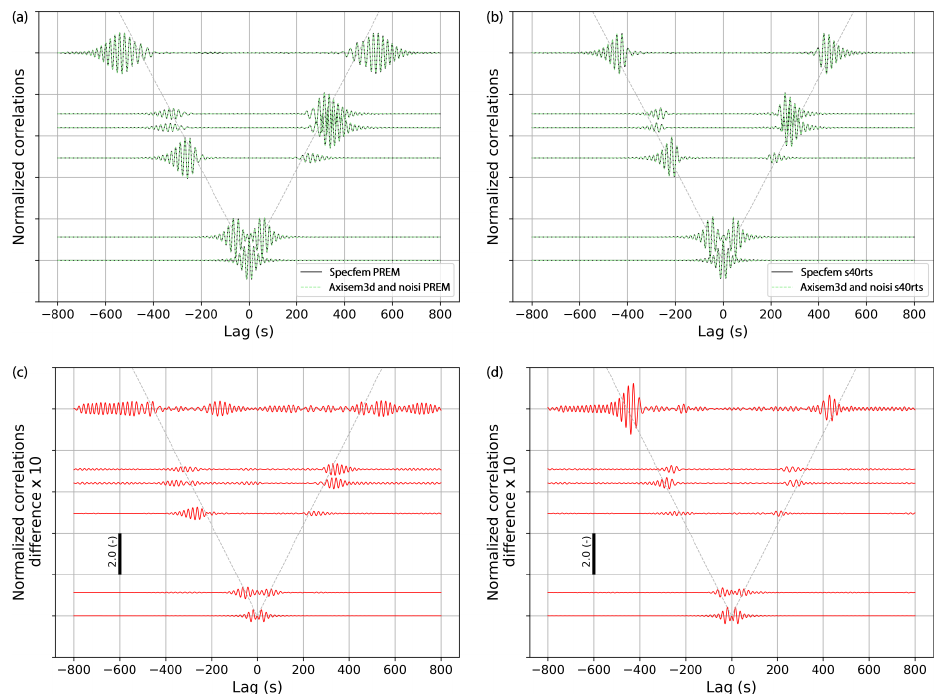
Figure 2. Comparison between two implementations of simulation ambient noise cross-correlations with PREM (a) and S40RTS (b) . Both panels shows correlations modeled with SPECFEM3D_GLOBE, as well as with noisi , in which the latter uses Green’s functions modeled with AxiSEM3D. A moveout of 3kms − 1 is shown by the dashed gray line (note that the y axis is only approximately to scale for better visibility; however, the cross-correlations for both models are arranged at the same distances). The correlations are low-pass filtered by a type II Chebyshev filter with a stopband frequency of 0.07Hz normalized to unity and arranged by inter-station distance. An overview of the modeling domain, stations, and mantle shear velocity model is shown in the Supplement. Panels (c) and (d) show the absolute difference between the traces in (a) and (b) enhanced by a factor of 10. The vertical bars denote the scale.